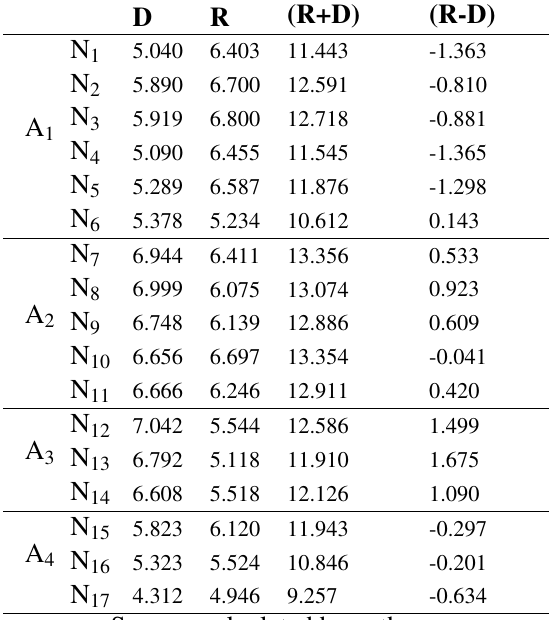
Table 4 The centrality of factors and cause-effect